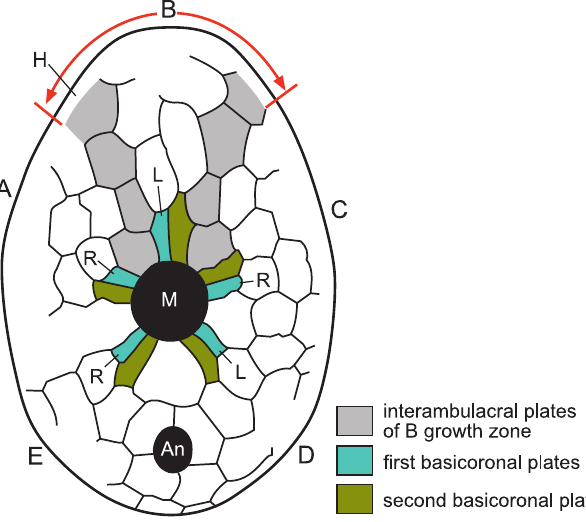
Fig. 1. Growth zone of ambulacrum B in the irregular echinoid Echino­ cyamus bisexus Kier, 1968, Eocene, Georgia, USA. An echinoid growth zone consists of four columns of plates, two central ambulacral columns the plates of which alternate, flanked by single columns of interambulacral plates (light grey shading). All the plates of a growth zone are added adja- cent to the ocular plate at the aboral tip of each ambulacrum (on the oppo- site surface of the echinoid). The first two ambulacral plates to form during growth, the basicoronal plates adjacent to the mouth (M), express Lovén’s Law. A, B, C, D, E, Carpenter’s (1884, 1891) ambulacra; An, anus; H, hy- dropore (madreporite) on the opposite surface of the echinoid; L, left; R, right, designate ambulacral columns; M, mouth. Modified from Paul and Hotchkiss 2020: fig. 3.